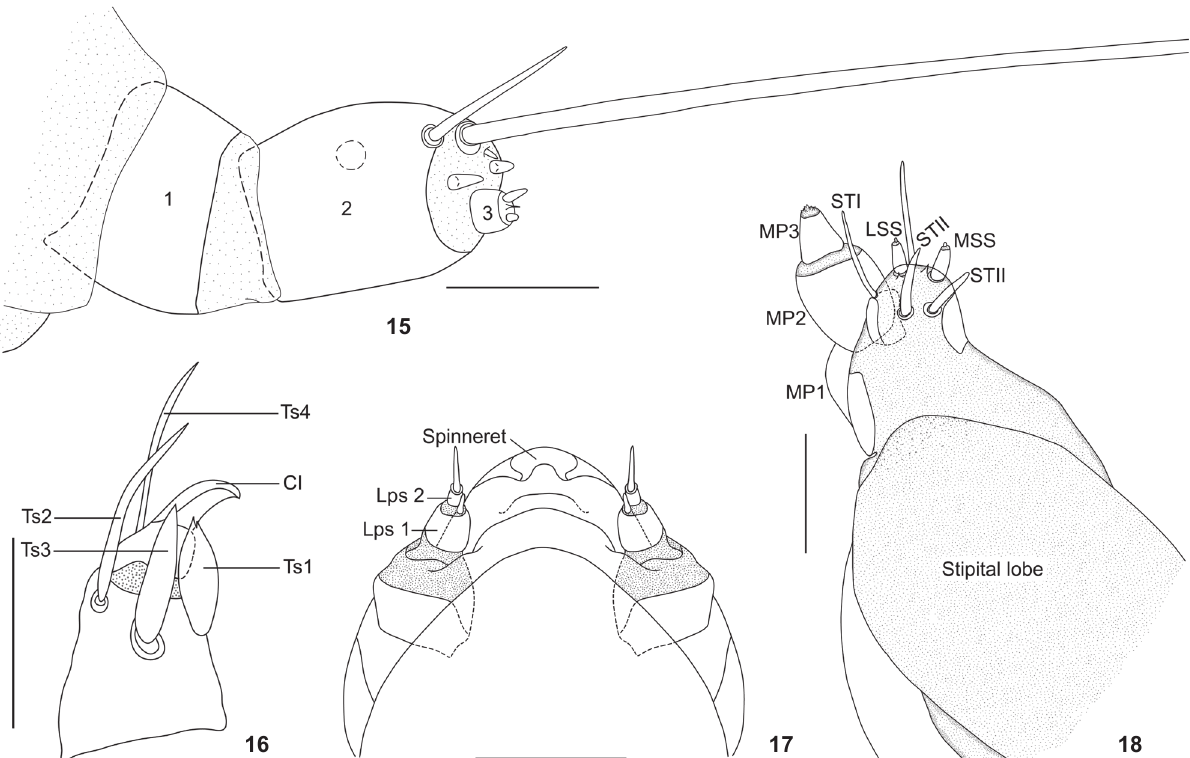
Figures 15-18. Last instar larva of L. dentilinea : (15) left antenna, lateral view; (16) Left pretarsus of mesothoracic leg, mesal view; (17) labium, dorsal view; (18) left maxilla, dorsoposterior view. (Cl) Claw, (Lps) labial palpus segment, (LSS) lateral styloconicum sensillum, (MP) segment of maxillary palpus, (MSS) medial styloconicum sensillum, (Sp) spinneret, (ST) sensillum trichodeum, (Ts) tarsal seta. Scale bar: 0.2